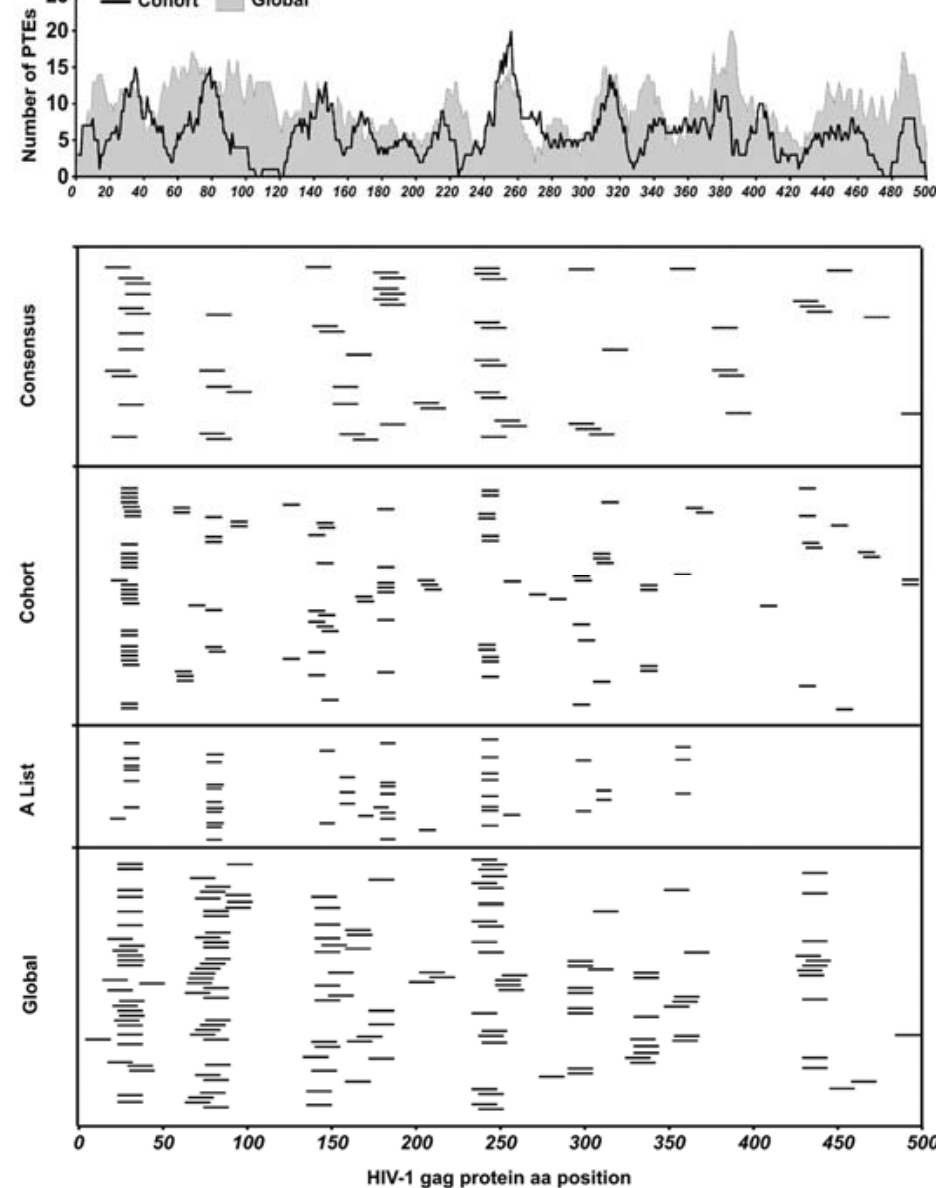
Figure 2. Peptide coverage and response epitope map. ( Top panel) All peptides in global and cohort PTE sets were aligned to the HIV-1 HBX2 Gag protein sequence to estimate the number of peptide sequence variants covering the sequence positions of the Gag protein by the global and cohort peptide sets by counting the number of amino acids aligned at each position. ( Bottom panels) Each peptide from the different peptide sets used in this study that elicited a positive CD8 T cell response was mapped to the HIV-1 Gag protein sequence to determine their relative locations along the Gag protein.